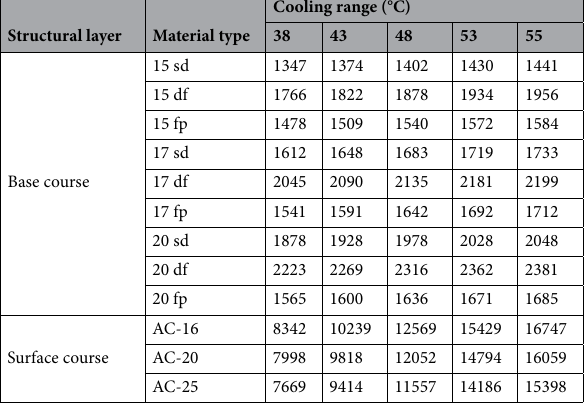
Table 3. Resilience moduli of the surface layer and the base layer (MPa).